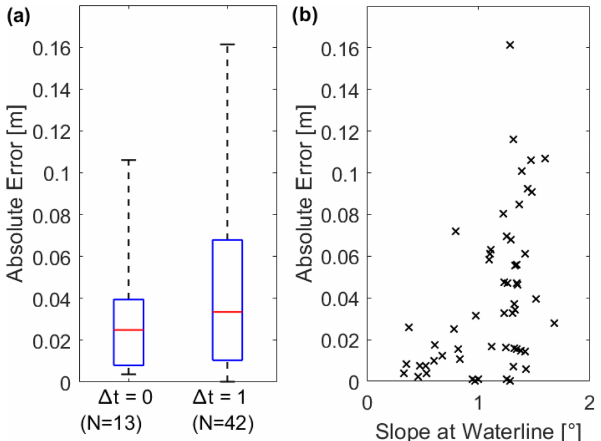
Figure 6. Analysis of the relative error between water surface heights (WSHs) extracted from Landsat 7 and 8 scenes as well as Sentinel-2 scenes. (a) Box plot of the absolute WSH error between scenes of the same ( (cid:49)t = 0d) and of subsequent days ( (cid:49)t = 1d). N is the number of scene pairs available for comparison. The cen- tral mark of each box is the median, the edges are the 25th and 75th percentiles, and the whiskers extend to the most extreme data points. (b) Average slopes of waterline pixels and absolute WSH error between scenes of the same or subsequent days ( (cid:49)t ≤ 1d).